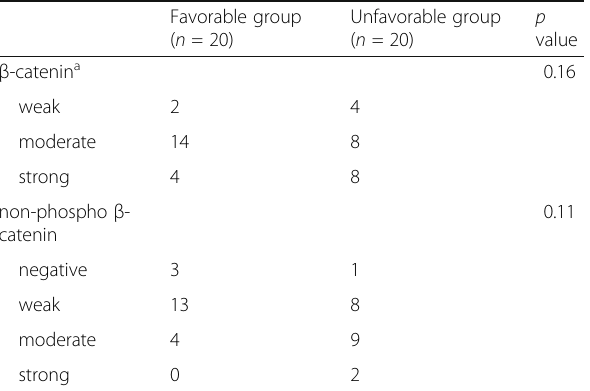
Table 3 Nuclear expression of β -catenin and non-phospho β -catenin. Relationship with clinical outcome of COX-2 inhibitor therapy